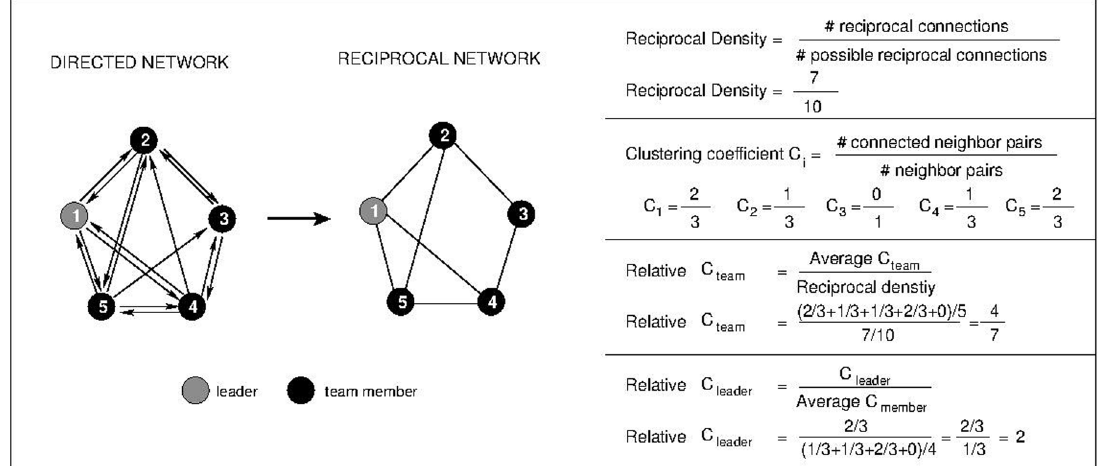
Fig 3. Illustration of social network analysis. As an exampleof a directednetwork of relationshipsbetweenpairs of neighborstaken from the survey (left diagram), we show how to obtain the reciprocal network and different network metrics: reciprocal density, the local clusteringcoefficient C i for each team member, the relative clusteringcoefficient of the team C team and the relative clusteringof the leaderC leader . In the left diagram, the directednetwork shows only positive interactions (‘Yes’ answersin the survey). Black nodesmark regularteam members, whereasthe grey node indicatesthe team leader. If two team members A and B have positive interactions A - > B and B- > A in the directed network, then there is a reciprocal interaction betweenA and B (right diagram). From the reciprocalnetwork of interactions, we computedthe quantitiesof interest as indicatedin the diagram. The symbol ‘#’ indicatestotal numbers.